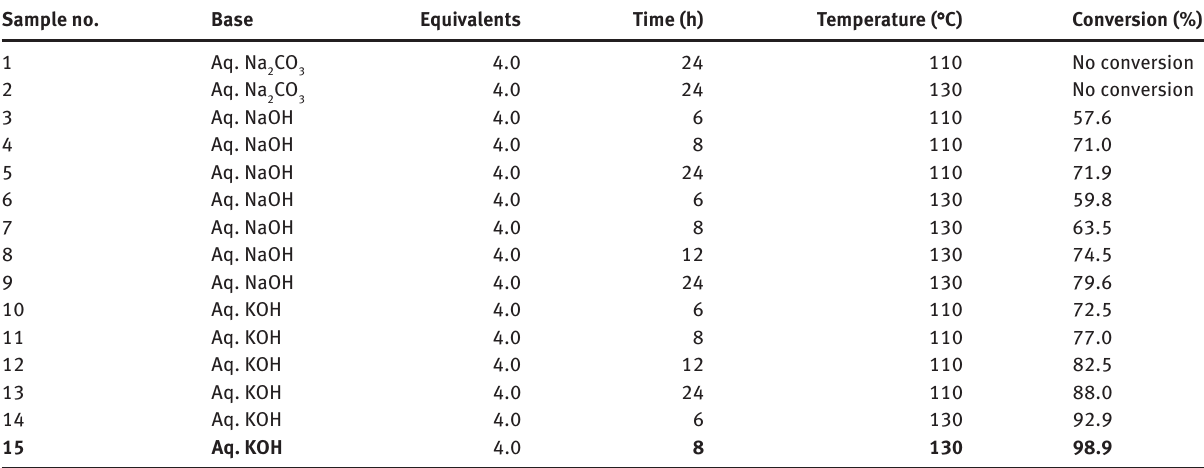
Table 1: Optimisation of reaction conditions for the preparation of 2-hydroxy-5-nitrobenzoic acid (2). Sample no.